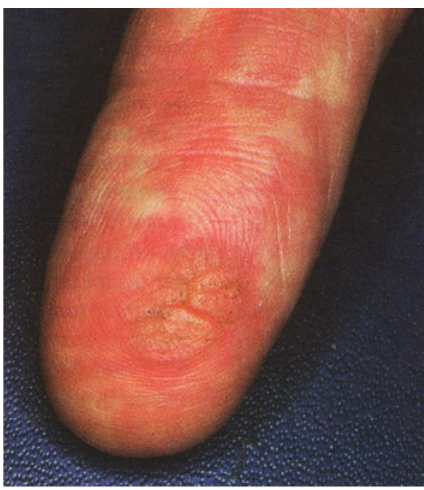
Figure 18: Warts [4, page 404].